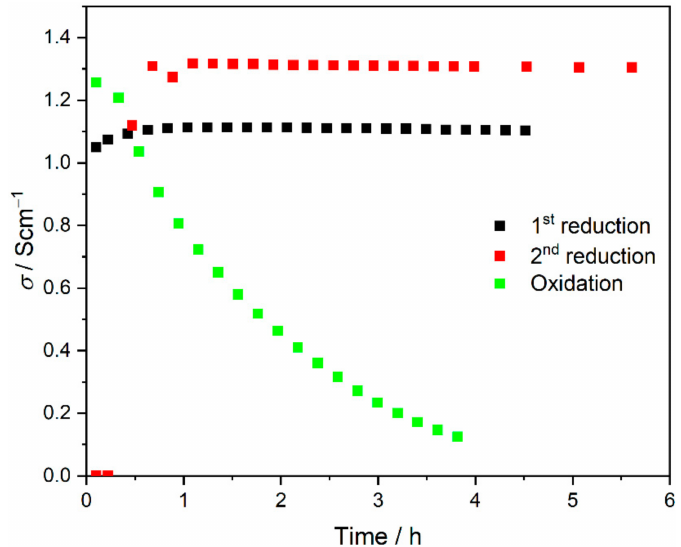
Figure 17. Electrical conductivity ( σ ) of the Ni–5CBCY reduced samples (black and red) and the sample undergoing oxidation (green) over time. All measurements were performed at 700 ◦